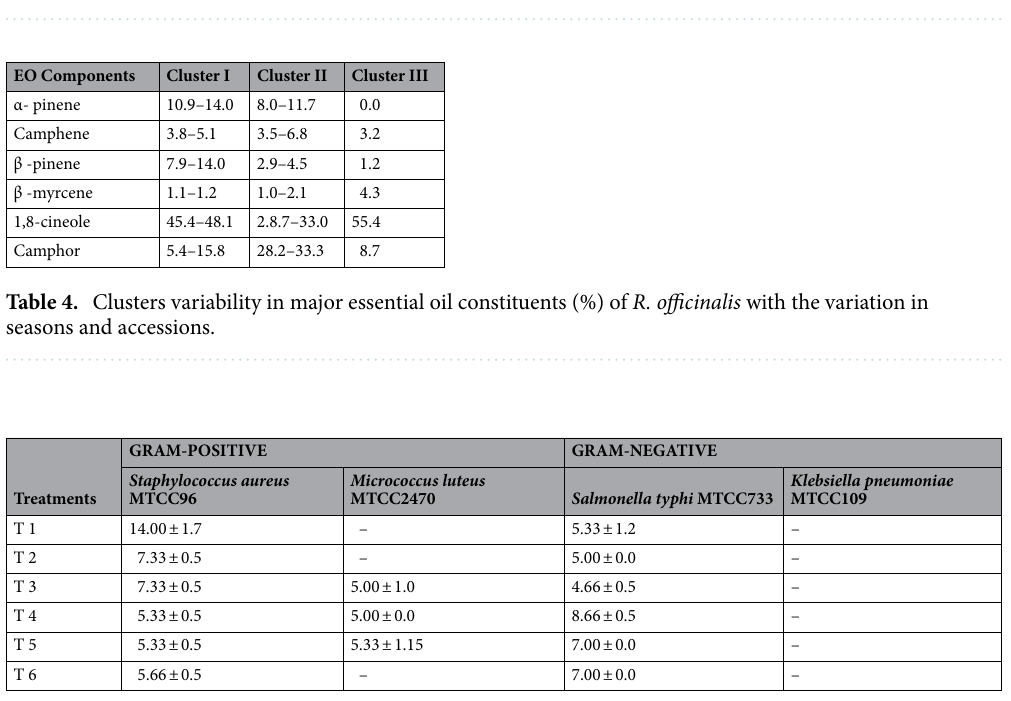
Figure 4. Loading plot of principal component analysis of different seasons and accessions ( a ) loading plot PC-1, ( b ) loading plot PC-2.